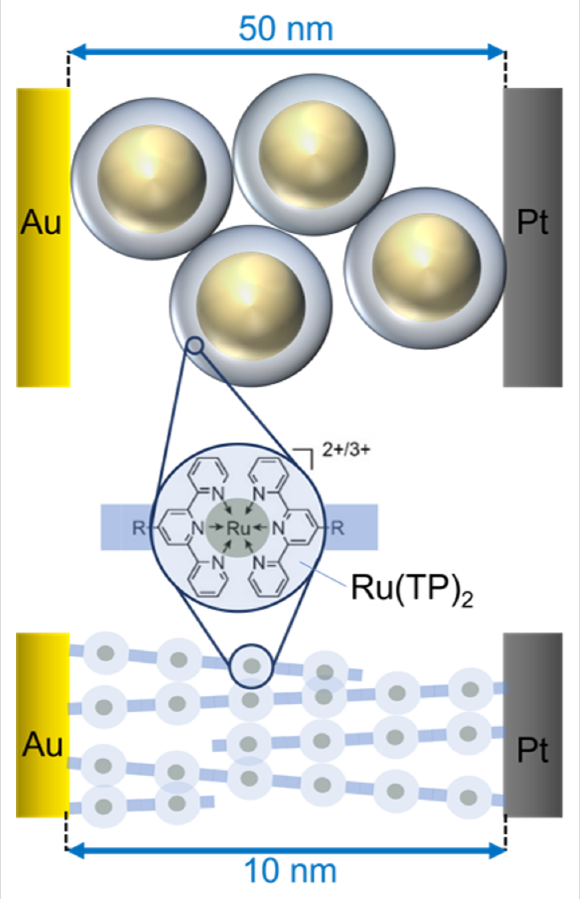
Figure 2: Schematic illustration of Ru(MPTP) 2 –AuNP (upper part) and Ru(TP) 2 -complex wire devices (lower left part) based on the same functional molecular unit, Ru(TP) 2 (not drawn to